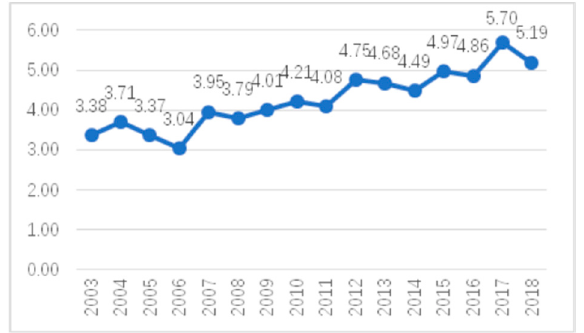
Figure 3. Average number of co-authors per article.